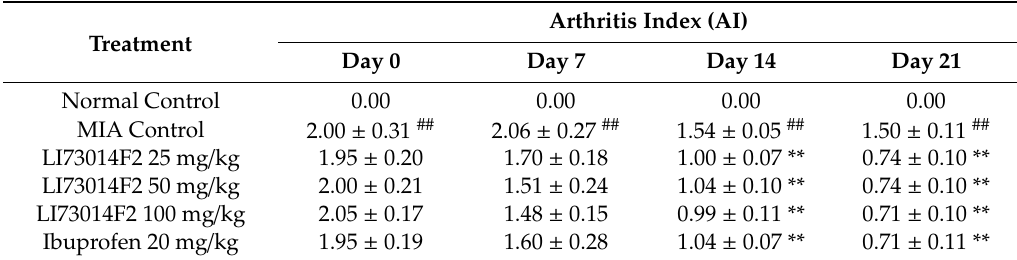
Table 2. Effects of LI73014F2 on arthritis index (AI) for 21 days in MIA-induced osteoarthritis in rats. The data are presented as mean ± SEM ( n = 8/group). ** p < 0.01, compared to the MIA-induced control group; ## p < 0.01, compared to the non-MIA-induced control group.